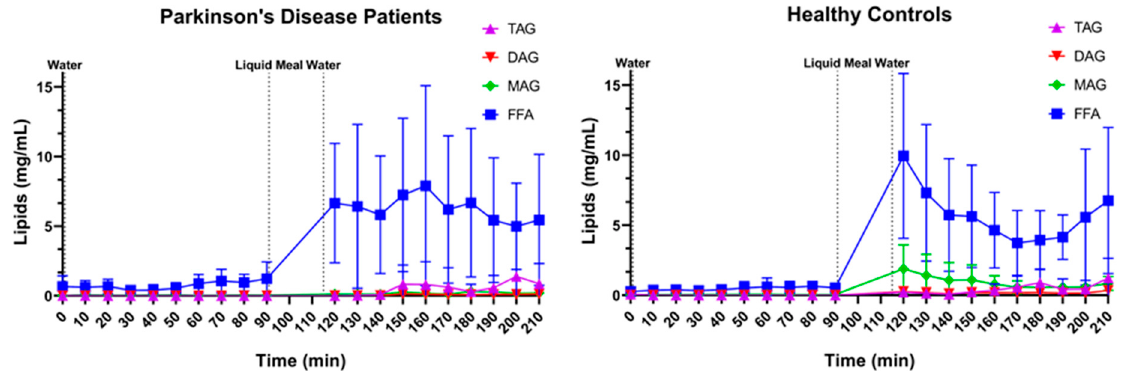
Figure 14. Lipid composition over time in Parkinson’s disease patients (left, n = 9) and healthy controls (right, n = 9). Data points represent mean concentrations ± standard deviation for the following lipid classes: free fatty acids (FFA, blue squares), monoacylglycerides (MAGs, green diamonds), diacylglycerides (DAGs, red inverted triangle) and triacylglycerides (TAGs, purple triangles). Vertical dotted lines indicate the ingestion of 100 mL of water or 200 mL of liquid meal.